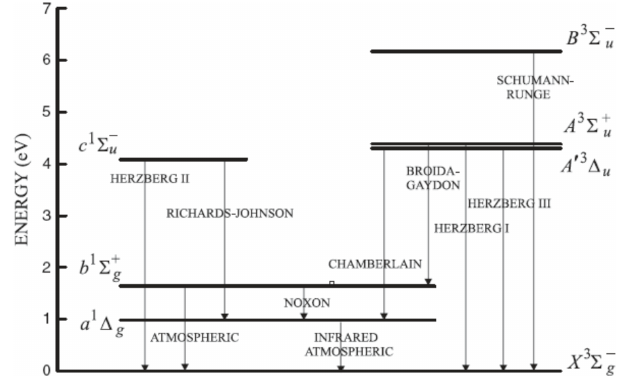
Figure A1. Energy levels of the various electronic states of the di- oxygen molecule (O 2 ) and names of electronic transitions between them (reprinted by permission from Springer Nature Customer Ser- vice Centre GmbH: Springer Verlag, Processes Responsible for the Occurrence of the Airglow by Vladislav Yu. Khomich, Anatoly I. Semenov, Nicolay N. Shefov, © 2008). The present study is rele- vant to the so-called “infrared atmospheric”